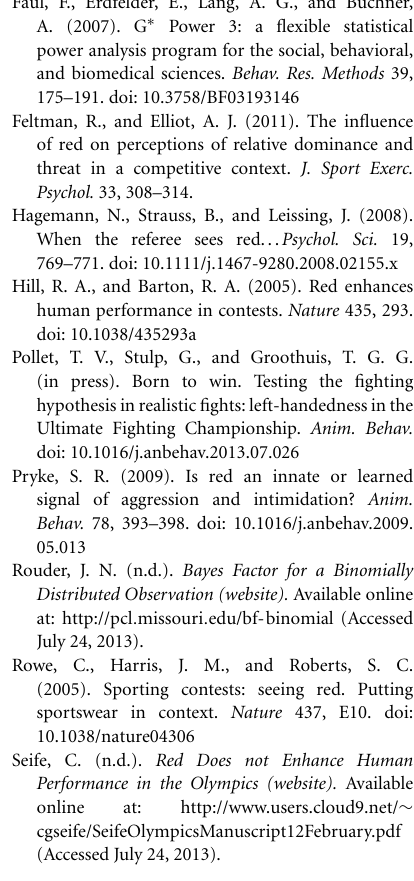
fight outcome ( p = 0 . 941 and p = 0 . 472,